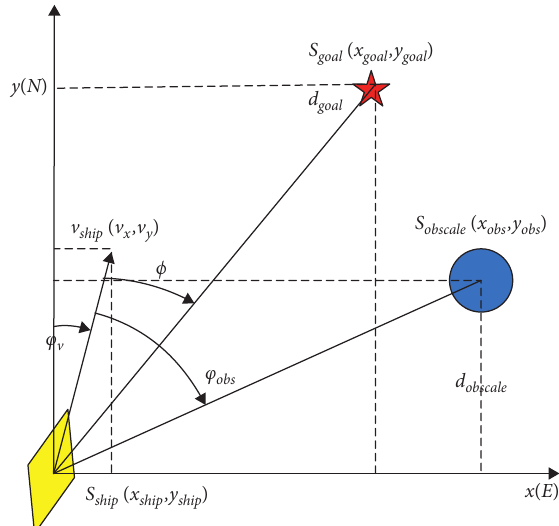
Figure 4: Information the ship sensed at time t